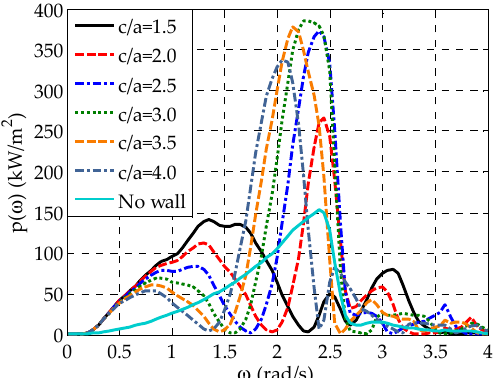
Figure 9. E ff ect of c / a on p ( ω ) of the array with semi-immersed oblate spheroidal WECs for l w / a = 36 Figure 9. Effect of 𝑐/𝑎 on 𝑝(𝜔) of the array with semi-immersed oblate spheroidal WECs for and l bet / a = 𝑙 (cid:3050) /𝑎 = 36 and 𝑙 (cid:3029)(cid:3032)(cid:3047) /𝑎 = 4 .